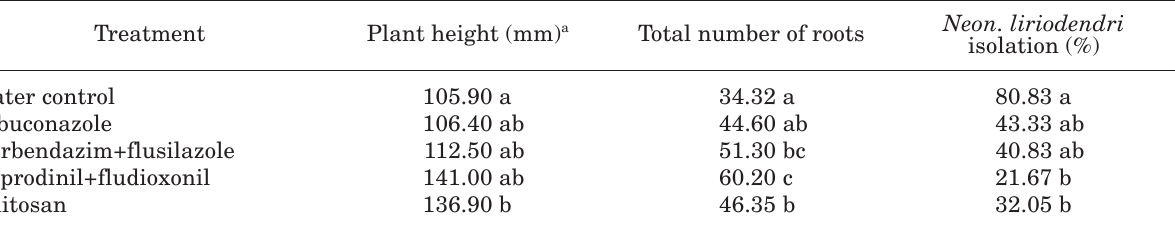
Table 4. Effects of chitosan and fungicides on grapevine plants of cv. Castelão (plant height and total number of roots) grown in substrate infested by Neonectria liriodendri and on fungal percent isolation. Treatment